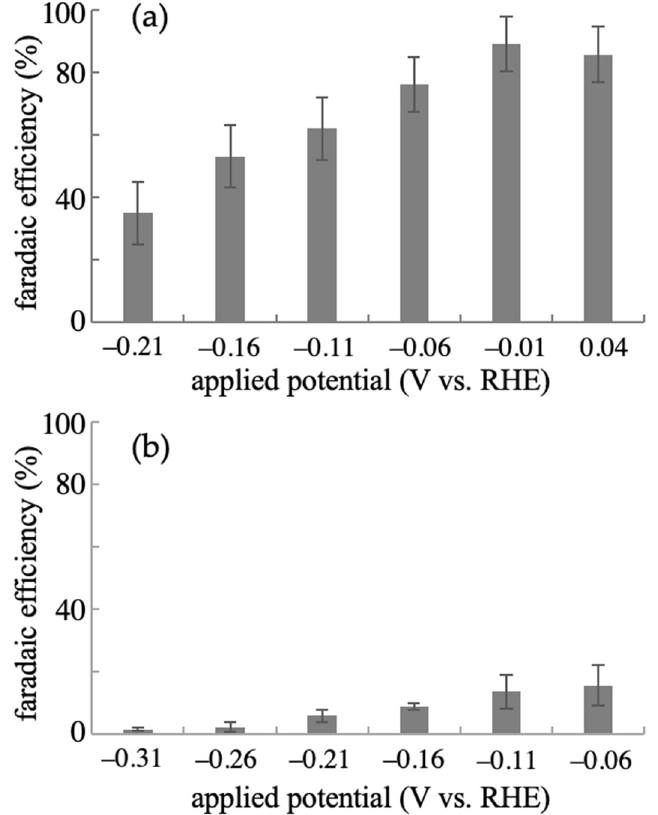
Figure 4. Relationship between FE of L-glutamic acid production and applied potentials for the electrolytic reaction of 50 mM of α -ketoglutaric acid in the presence of 50 mM of NH 2 OH using ( a ) NPG and ( b ) planar-gold electrodes. FE values are presented as mean ± SD ( n = 3 independent experiments).